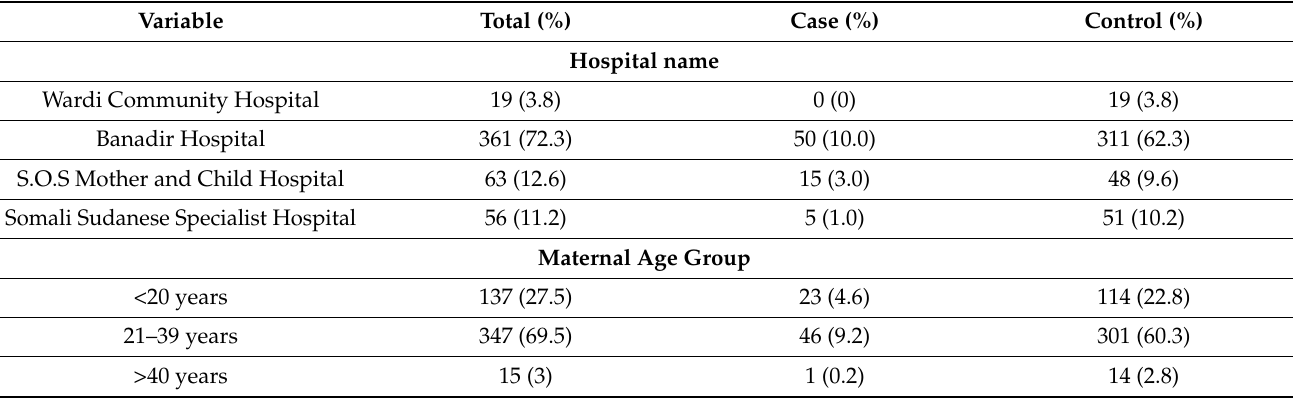
Table 1. Socio-demographic characteristics of pregnant women in Mogadishu ( N =